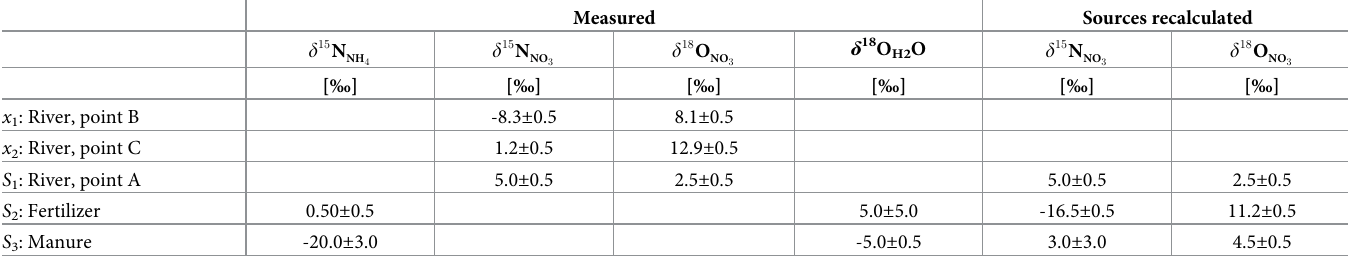
Table 6. Summary of input values for the FRAME model. Source recalculated signatures reflect fractionation during NO 3 generation. δ 18 O is the stable isotope composi- tion of water in the place of NO 3 formation surface water in trenches contaminated by manure (-5.0 ± 0.5 ‰) and soil moisture (5.0 ± 0.5 ‰).